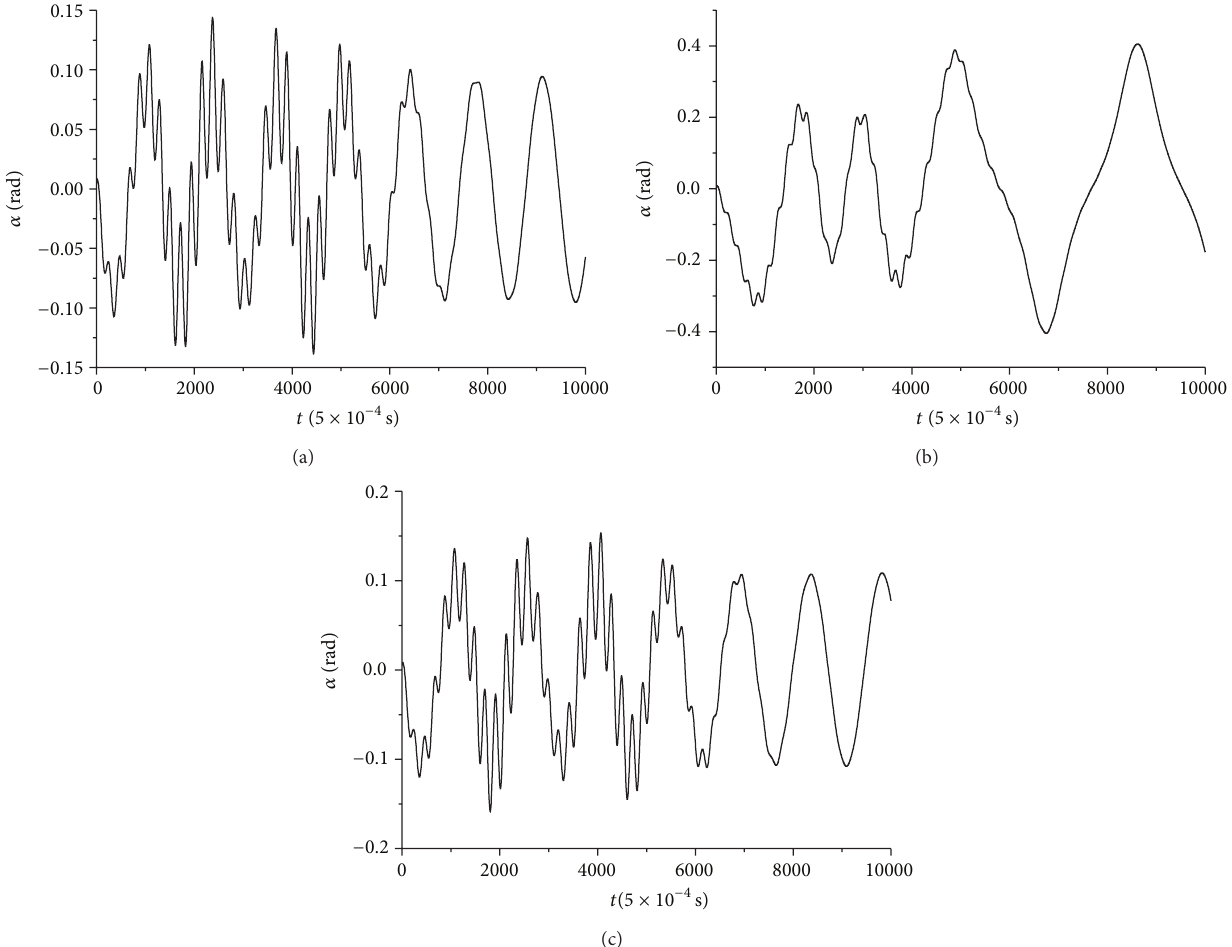
Figure 3: Roll angle 𝛼 time-series for rattlebacks made of (a) wax (b) gypsum, and (c)